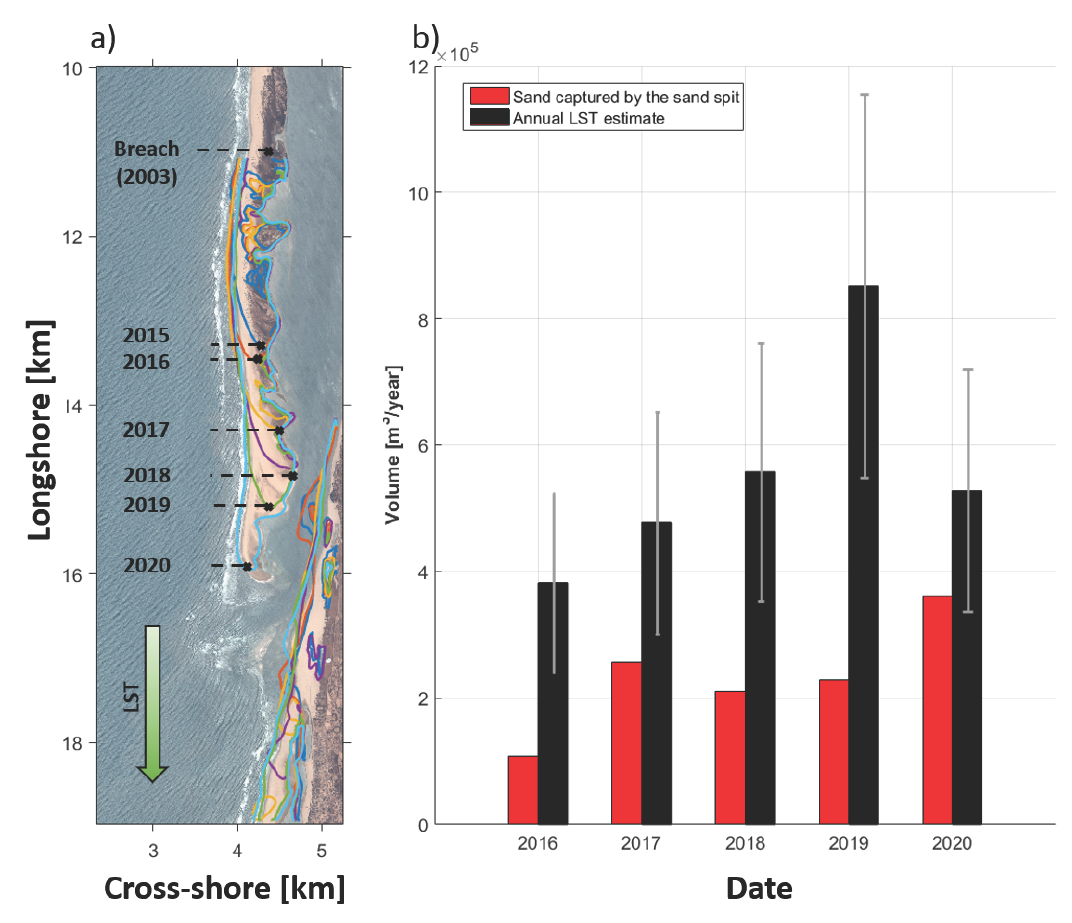
Figure 5. ( a ) Sand spit tip’ position and shorelines derived from S2-satellite over time using Coastsat Open-Access tool [44]. ( b ) Volume of sand annually captured by the sand spit (red) compared to the annual LST estimates obtained from ERA5 data (black) with its standard deviation